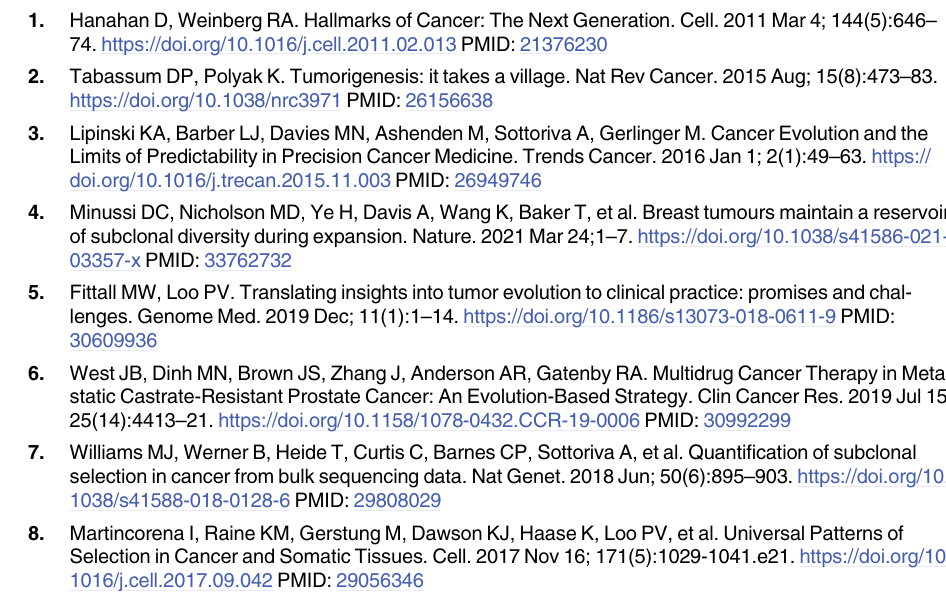
S4 Table. SciClone empirical estimates. sciClone estimates in 78 PCAWG samples. Default settings as outlined in sciClone package were used. VAFs were filtered above 5% VAF and below 100% VAF before application of sciClone. Only diploid regions were used. The esti- mated number of subclones was taken as the number of clusters detected by sciClone minus 2 (1 for clonal peak and 1 for neutral tail). If a sample was labeled -1 (e.g. only a clonal peak) it was called as 0 subclones. (XLSX) S5 Table. TEMULATOR simulation parameters. Simulation parameters used for generating additional synthetic data using an alternative simulation framework.